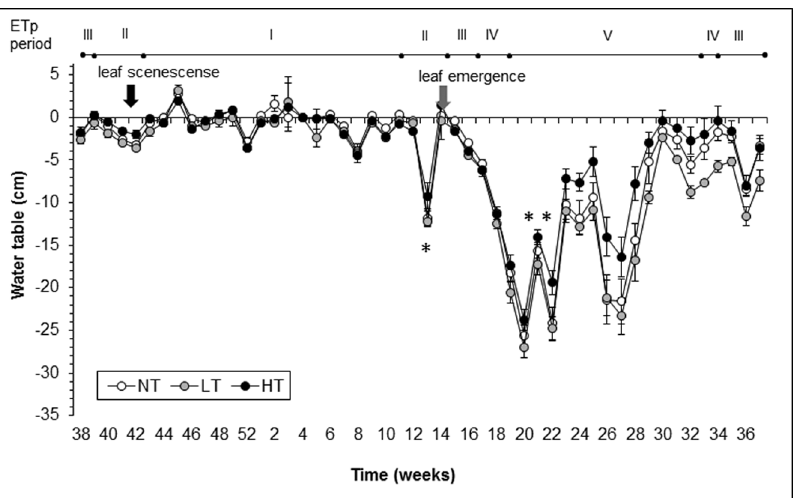
Figure 2. Seasonal changes in tree density effects on mesocosm water table. Bars represent mean water tables 6 1 SE (n=5) in cm relative to a fixed point per week, from week 38 in 2007 (38) until week 37 in 2008 (37). Positive values indicate a water table closer to the surface. Water table level was measured relative to a fixed point (the overflow outlet), which was 10–15 cm below the moss surface. Birch density treatments are identified by differently shaded bullets. NT=control without trees, LT=low tree density, HT=high tree density. Arrows indicate onsets of leaf senescence in 2007 and leaf emergence in 2008. *=week during which storage coefficient has been determined, ** week in which demineralized water has been added to each mesocosm. ETp periods indicates periods (I-V) differing in solar radiation and potential evapotranspiration, over which evapotranspiration has been averaged for Figures 1, 3 and 4. Note: mesocosm trees were planted in December 2007.